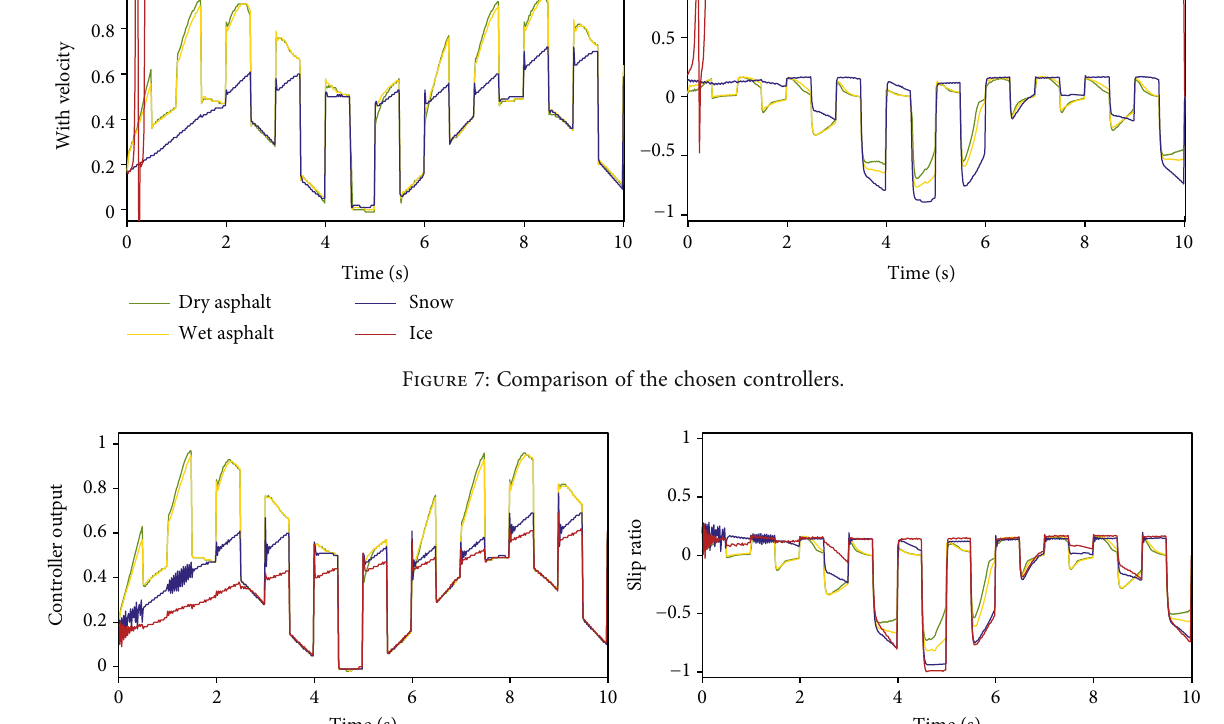
Figure 8: Evaluation of the controller trained on ice and dry